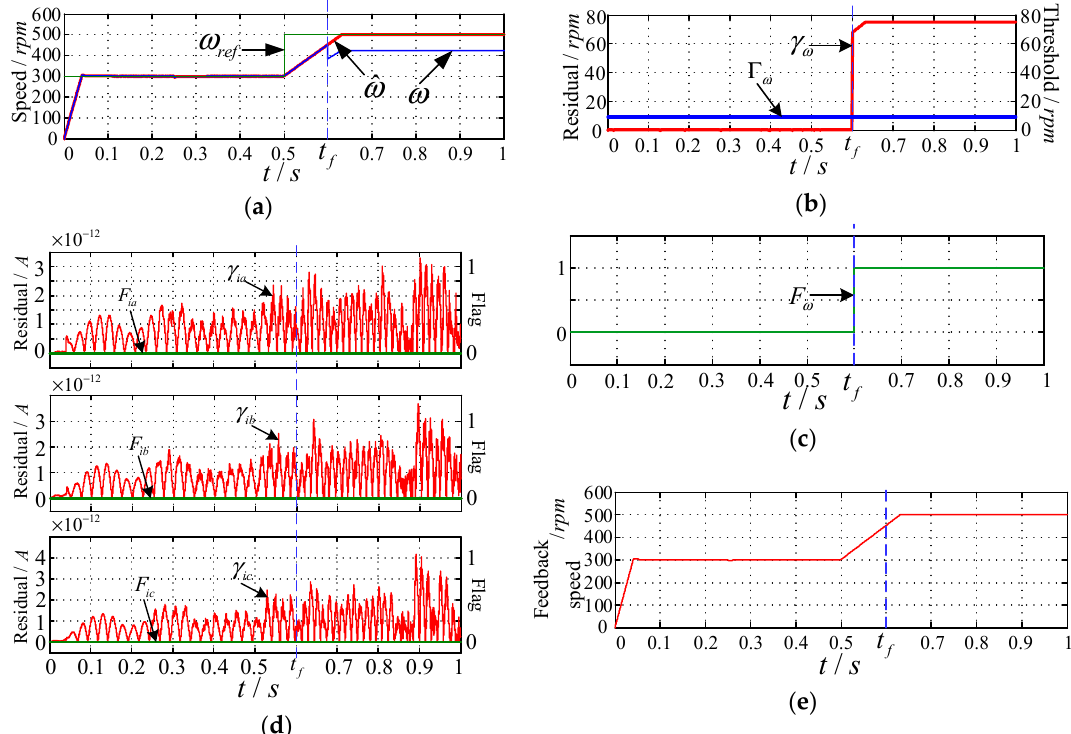
Figure 8. The system simulation waveforms in the case of speed sensor constant gain fault. ( a ) The given speed ω ref , measured speed ω and estimated speed ˆ ω ; ( b ) Speed residual γ ω and threshold Γ ib ; ( c ) The fault flag F ω of speed sensor; ( d ) Three-phase current residuals and fault flags; ( e ) Closed-loop feedback speed ω r .